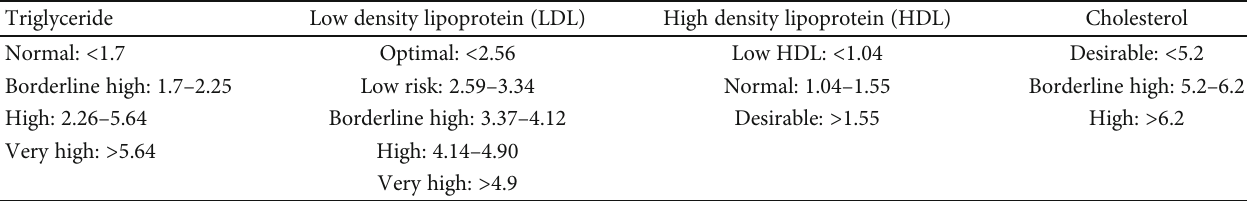
Table 1: The National Cholesterol Education Program (mmol/L). Triglyceride Low density lipoprotein (LDL) High density lipoprotein (HDL)